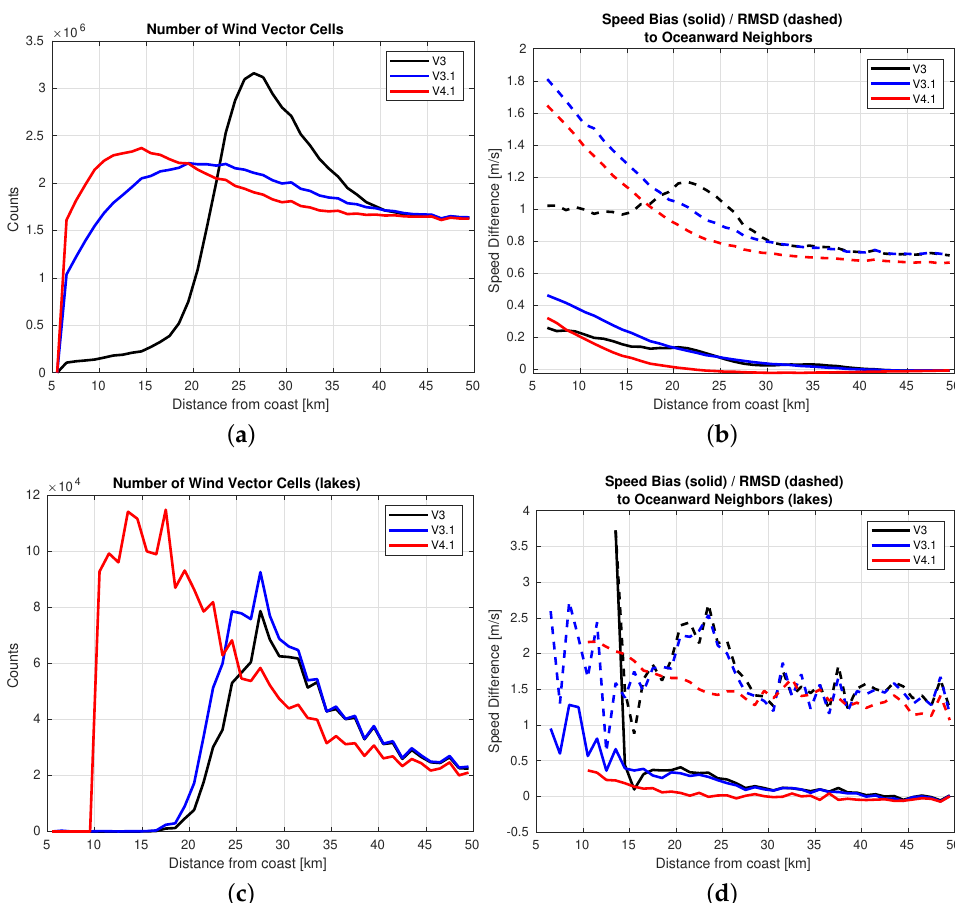
Figure 8. ( a ) Number of WVCs as a function of distance to nearest coastline, for QuikSCAT V3, V3.1 with LCR, and V4.1 with LCRES. ( b ) Speed bias versus oceanward neighbors, as a function of distance from nearest coastline, for the same datasets. ( c ) Same as upper-left but statistics only computed over large inland lakes with respect to lakeward neighbors. ( d ) Same as upper-right but statistics only computed over large inland lakes. We see many more WVCs near to coast in the LCRES method of processing than in V3 QuikSCAT without any coastal processing, and an improvement as compared to using just the LCR method. On the lower-right plot we note that the performance degradation close to coast is minimal as we get close to the